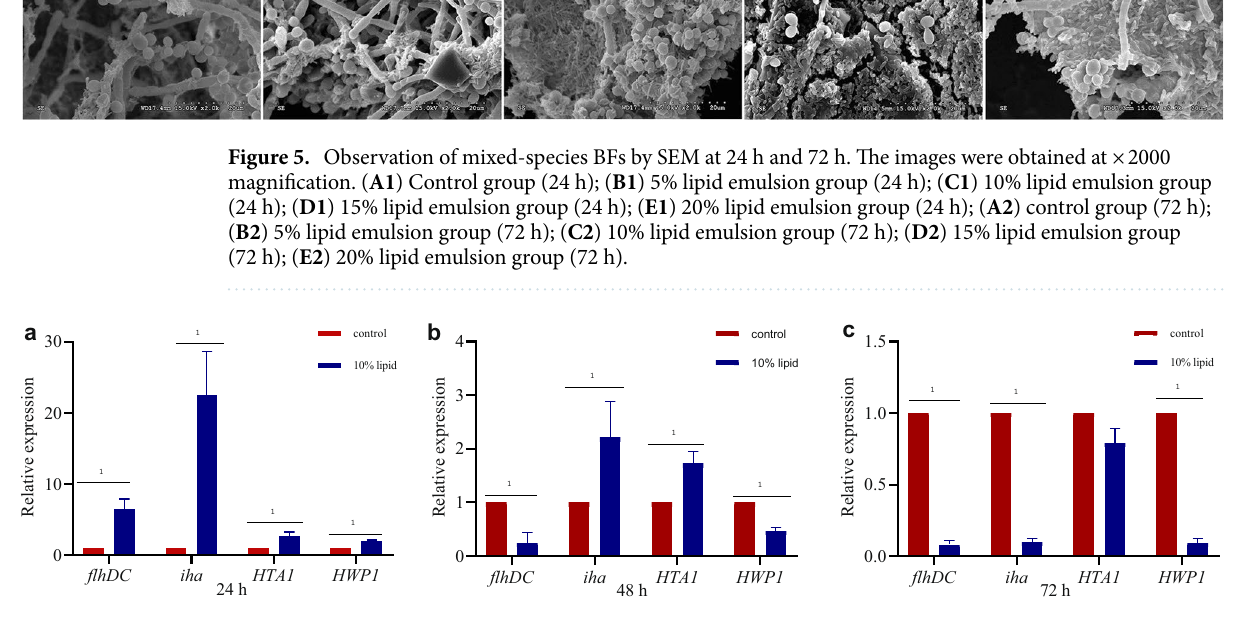
Figure 6. Comparison of qRT-PCR results of gene expression at 24, 48, and 72 h between the control group and the 10% lipid emulsion group, 1 P <